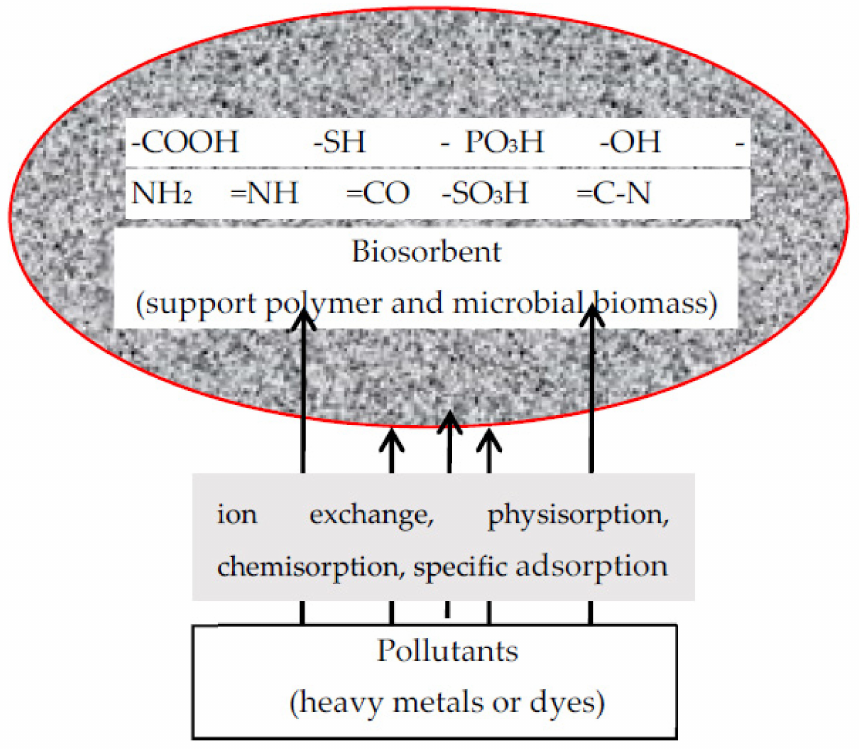
Figure 4. Schematic representation of biosorption mechanism of specific